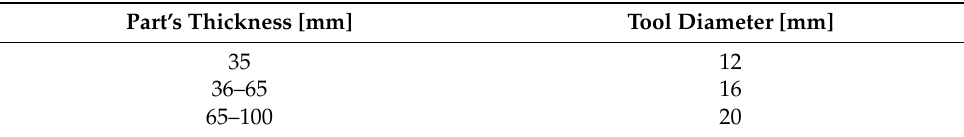
Table 4. Different tool diameters chosen in function of part’s